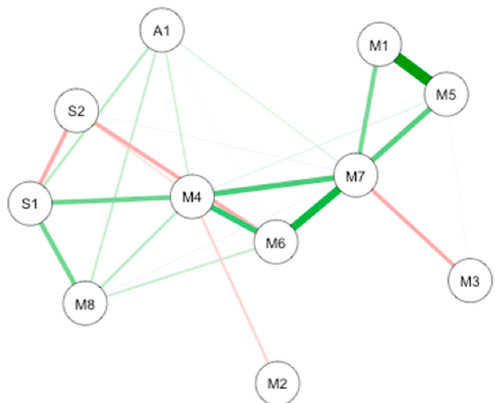
Figure 3. GLASSO-regularized partial Pearson correlation networks of interoception subscales, mindfulness subscales, and subjective olfactory acuity, resulting from all the subjects. Green edges denote positive associations, red edges negative ones. S1 SPANE positive emotion; S2: SPANE negative emotion; F1: FMI presence; F2: FMI Non-judgmental acceptation; M1: MAIA noticing; M2: MAIA not distracting; M3: MAIA not worrying; M4: MAIA attention regulation; M5: MAIA emotional awareness; M6: MAIA self-regulation; M7: MAIA body listening; M8: MAIA trusting; A1: Subjective olfactory acuity.